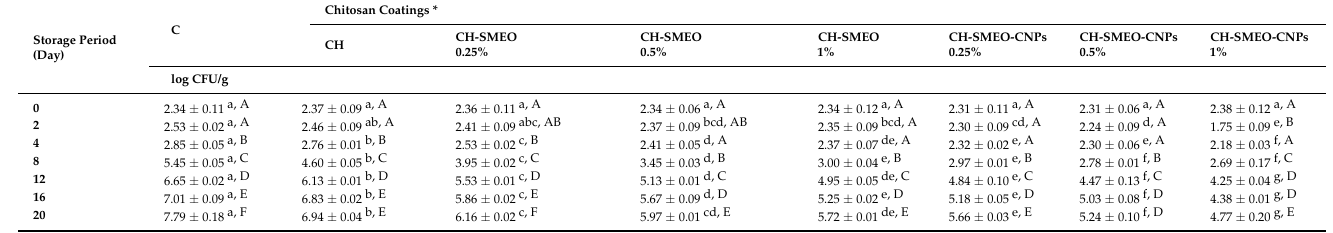
Table 4. Effect of the addition of chitosan coatings and chitosan-based nanoparticles enriched with Satureja montana L. essential oil on the change in the number of Pseudomonas spp. in beef samples during storage.